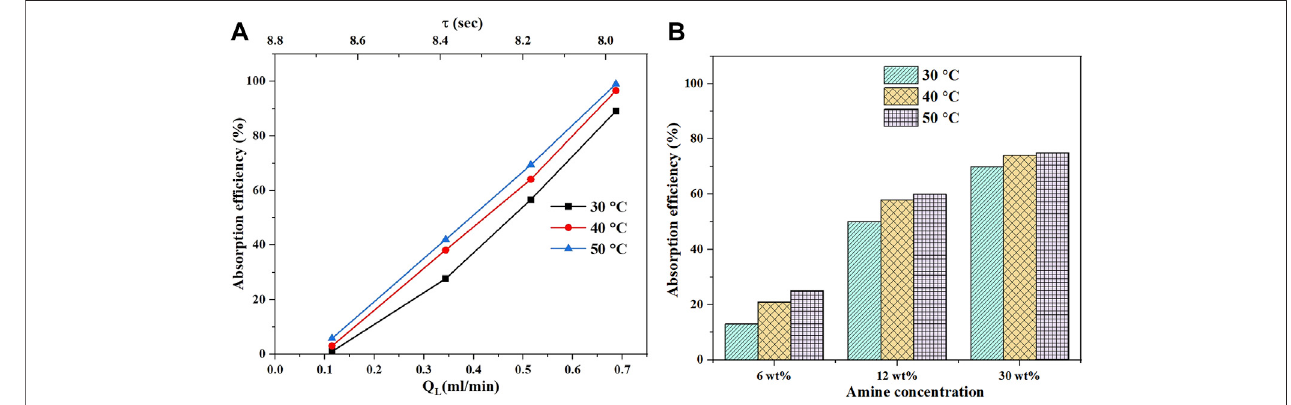
FIGURE 7 | CO 2 fl ow rate effect on the absorption ef fi ciency (A – C) at different amine concentrations and a fi xed temperature of 30 ° C. The absorption ef fi ciency of MEA at different temperatures (D) with two CO 2 gas fl ow rates of 6 and 9 ml/min and a constant liquid fl ow rate Q L of 0.5 ml/min.